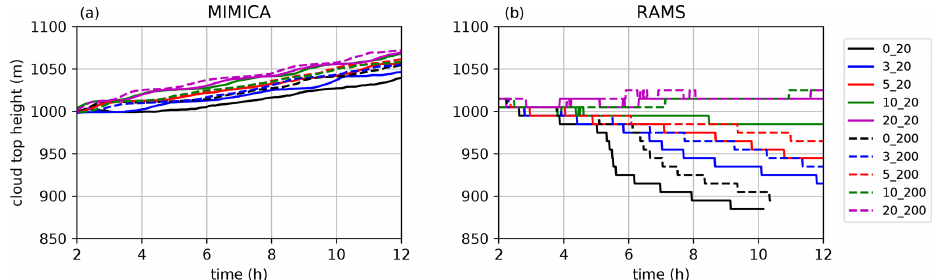
Figure A3. Cloud top heights in (a) MIMICA and (b) RAMS. The first 2h of simulations, considered as the spin-up period, are excluded.